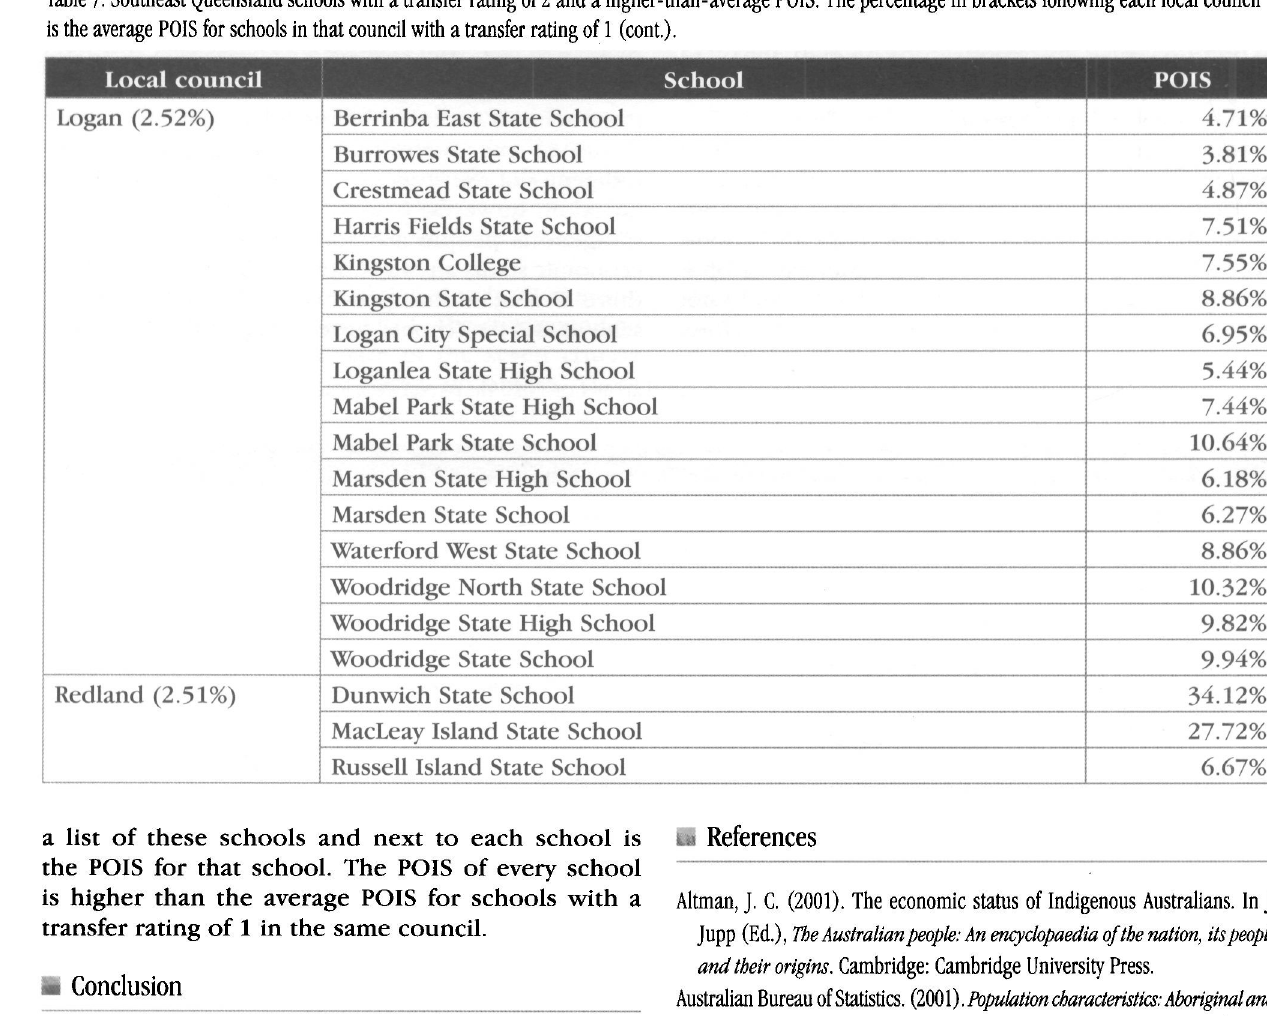
Table 7. Southeast Queensland schools with a transfer rating of 2 and a higher-than-average POIS. The percentage in brackets following each local council is the average POIS for schools in that council with a transfer rating of 1